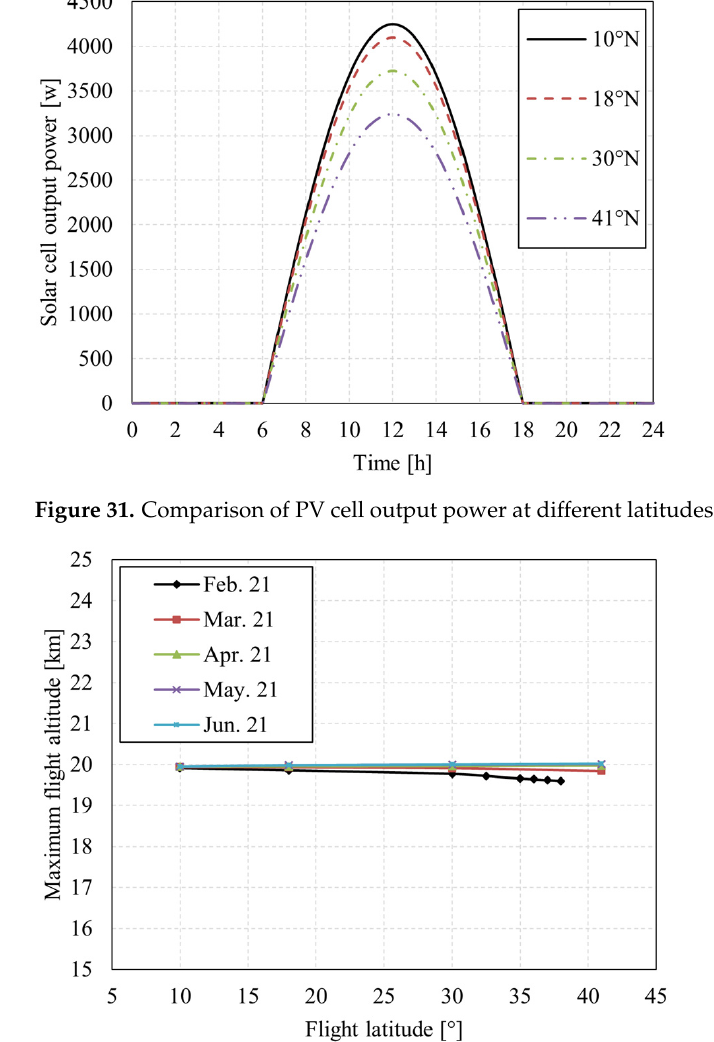
Figure 32. Influence of flight latitude on maximum flight altitude.